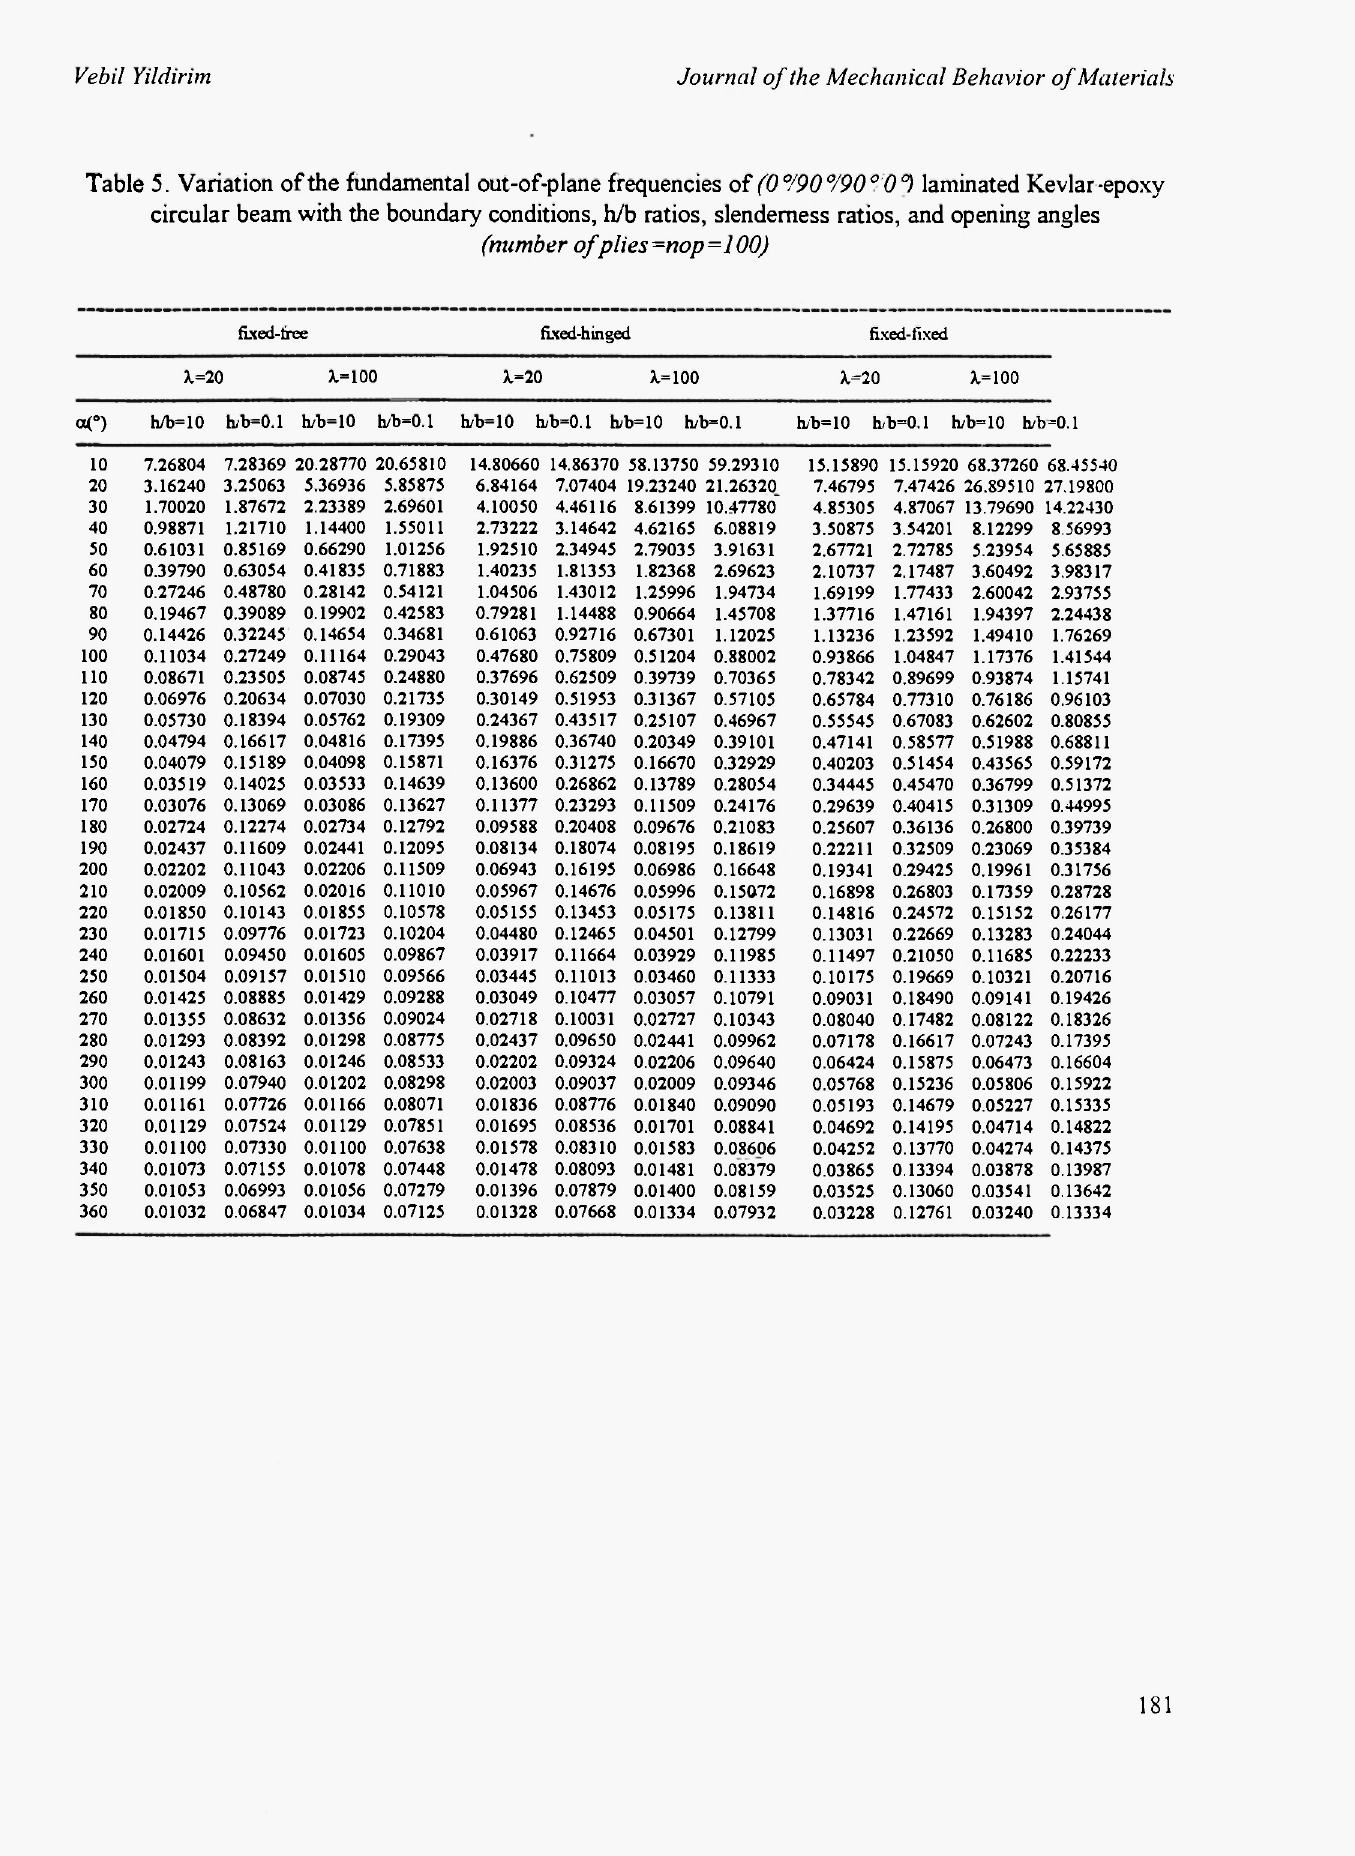
Table 5. Variation of the fundamental out-of-plane frequencies of (0 °/90 °/90 ° 0 laminated Kevlar-epoxy circular beam with the boundary conditions, h/b ratios, slendemess ratios, and opening